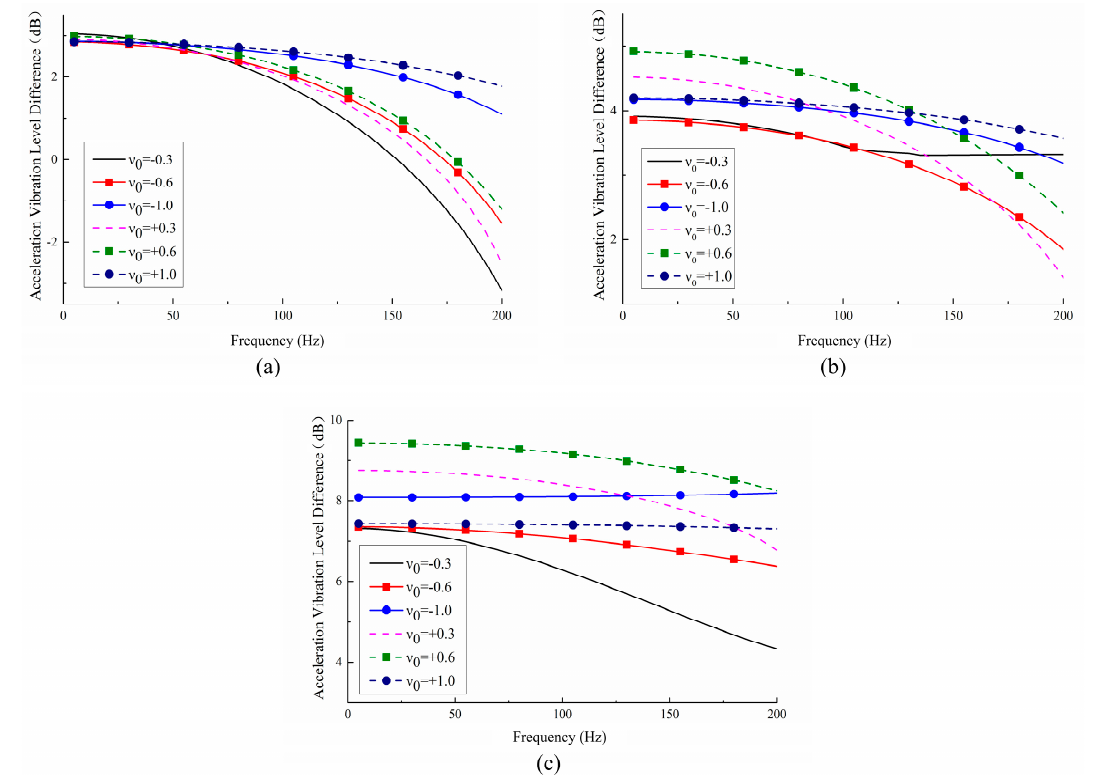
Figure 13. Influence of PR values on the VLD between measuring points: ( a ) A and B; ( b ) B and C; ( c ) C and D.